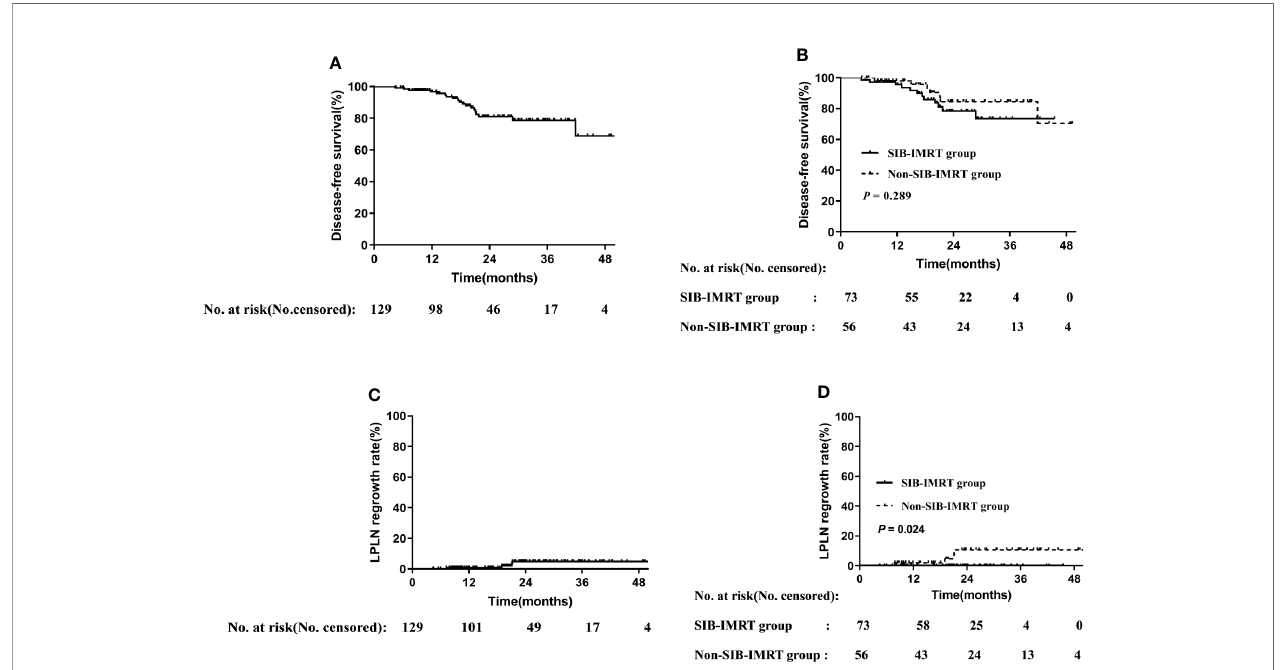
FIGURE 1 | Disease-free survival rate in overall cohort (A) and in subgroups of whether receive SIB-IMRT (B) . LPLN regrowth rate in the overall cohort (C) and in subgroups of whether receive SIB-IMRT (D)